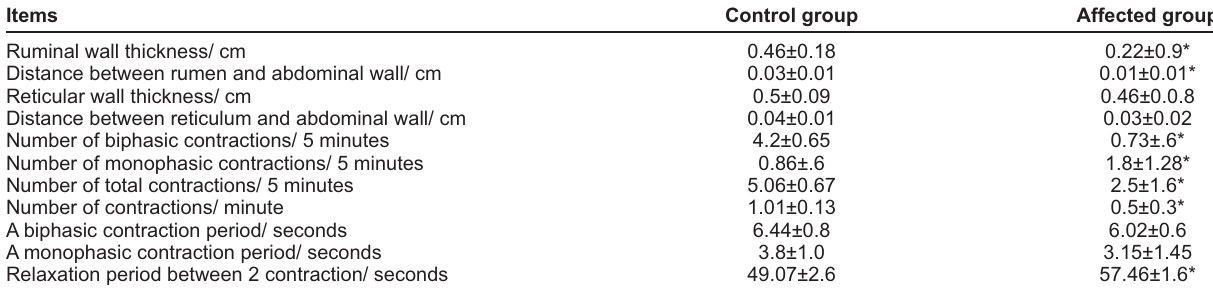
Table-3: Hematological and biochemical differences between healthy control and foreign body impacted goats.